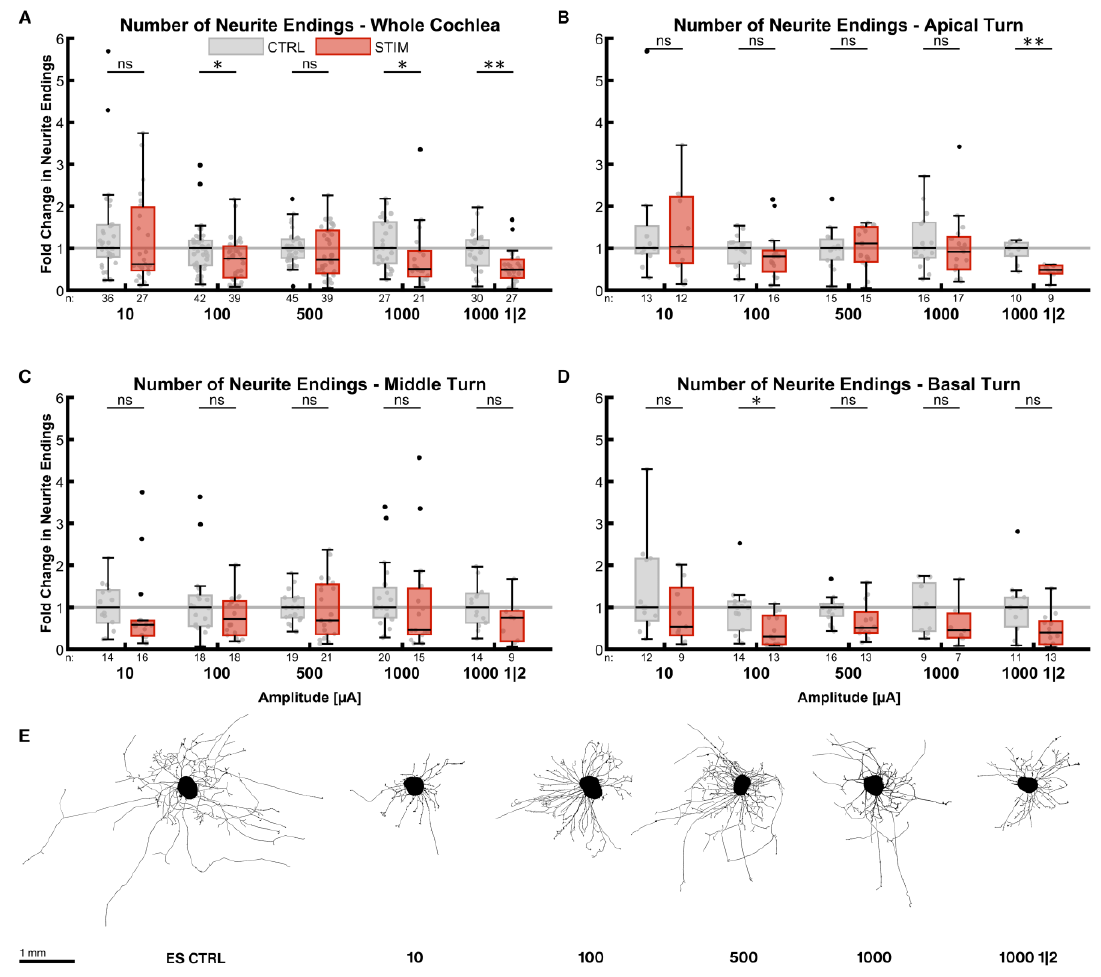
Figure 3. Number of neurite endings after electrical stimulation. The diagrams ( A – D ) show the fold change of the number of neurite endings regarding the median of the control group after ES with different amplitudes. All groups were supplemented with 25 ng/mL BDNF. The fold change was normalized to the electrically unstimulated controls on the same plate. Therefore, every electrically stimulated group has its own unstimulated control group. 1000 1|2 designates the 1 min on, 2 min off stimulation pattern with 1000 µA amplitude. The groups in the first graph ( A ) contain an equal number of samples from three turns, hence representing the whole cochlea. Diagrams ( B – D ) depict the individual turns. ( A – D ) The boxes extend from the 25% to the 75% percentile. The black bar denotes the median. The whiskers delimit the 1.5-fold interquartile range. Samples within this range are marked as grey dots, and samples beyond this range are black. A grey line marks the median of the control group. The number of samples in each group is written right below the X-axis. The asterisks or ns (not significant) above the groups indicate the significance level of a groupwise Mann–Whitney test, followed by a Holm–Š í d á k correction against the corresponding control group. ( E ) Representative explants at the median of the best-performing groups in ( A